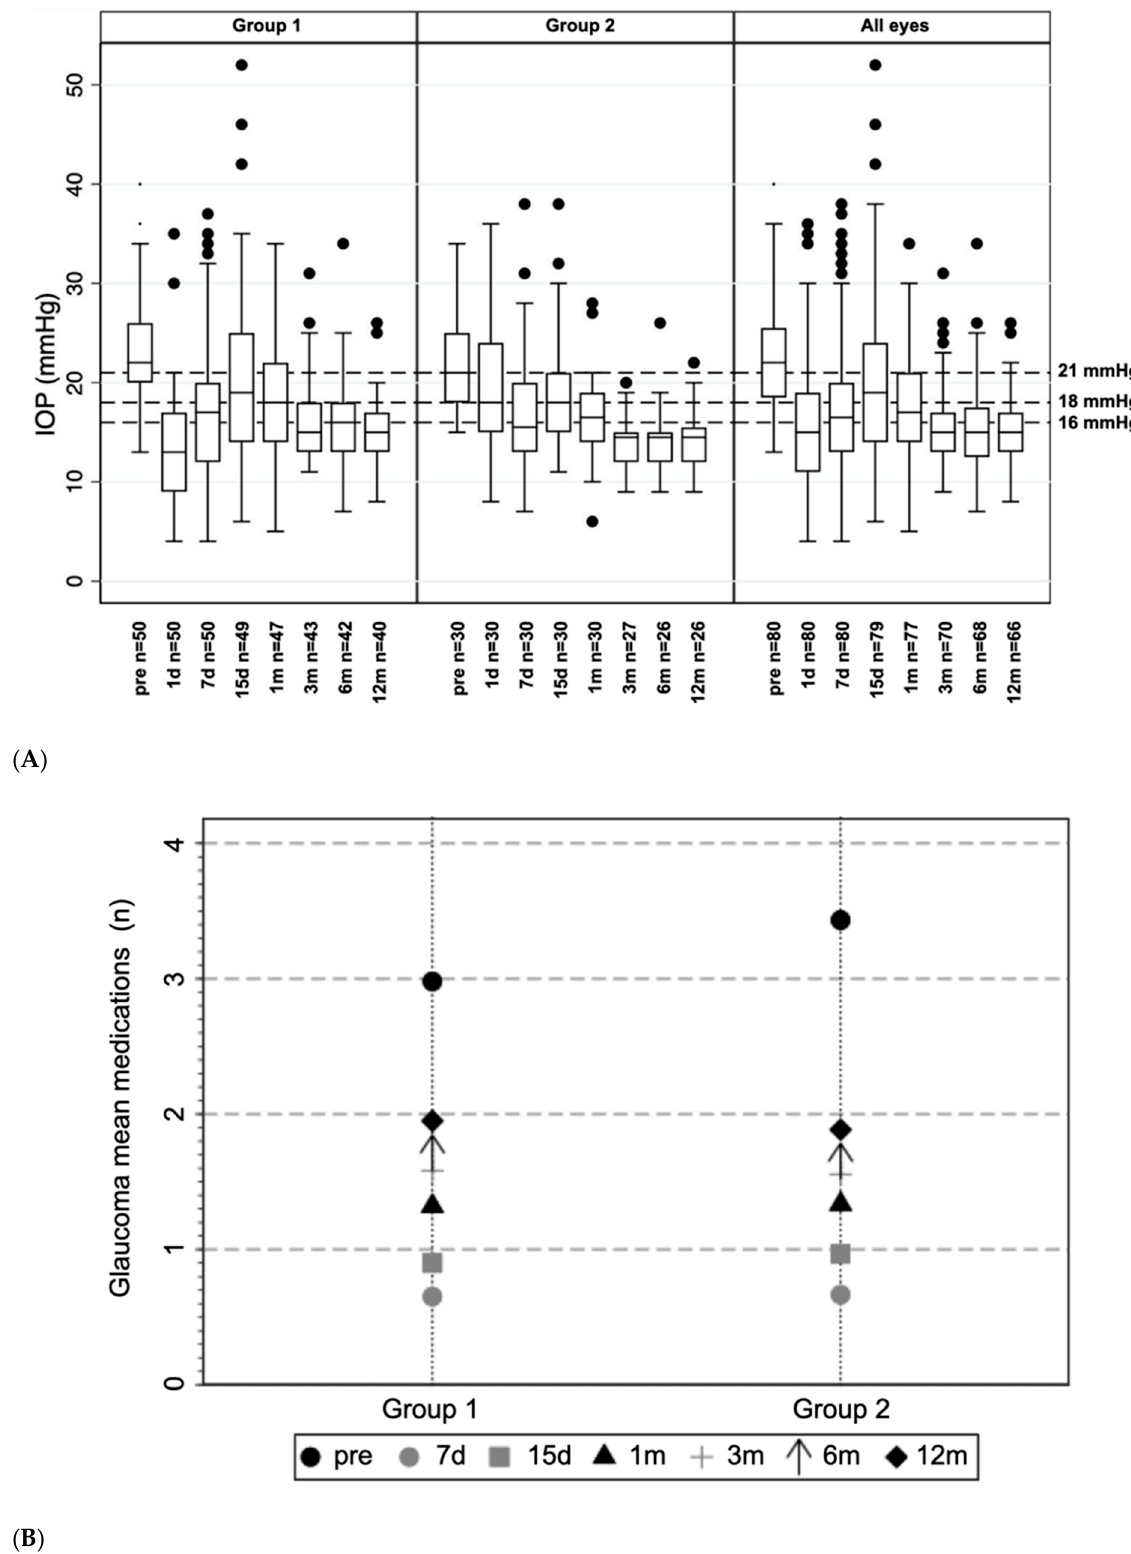
Figure 2. Boxplot of IOP distributions at baseline and at each follow-up visit for Groups 1 and 2 and for all the cohort (( A ), above). Mean medications at the baseline and at each follow-up visit in Groups 1 and 2 (( B ), below).